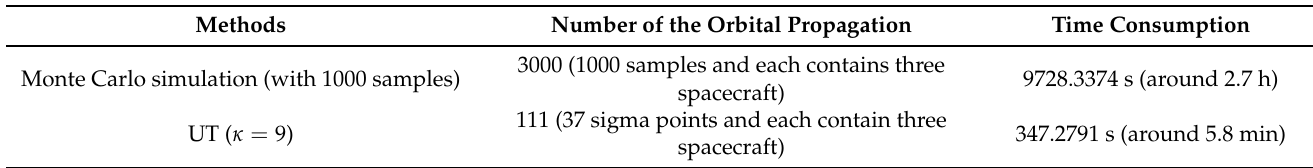
Table 6. Run time of a 5-year configuration uncertainty